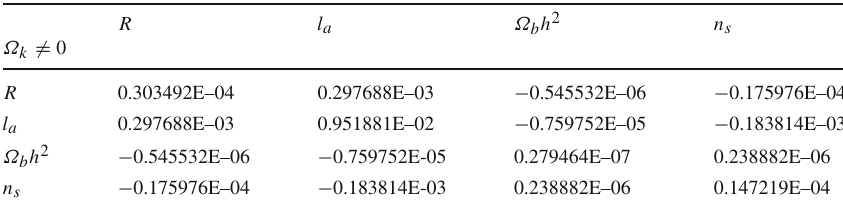
Table 17 Covariance matrix for ( R , l a ,Ω b h 2 , n s ) from Planck